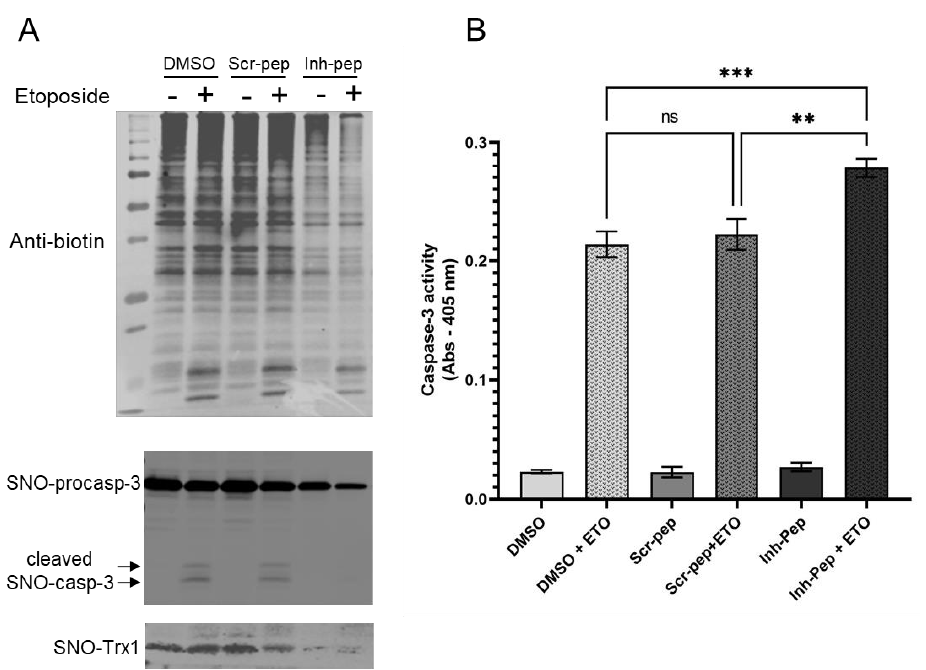
Figure 4. Inhibitory peptide by reducing S-nitrosation in Jurkat T cells increases etoposide-dependent caspase-3 activity. ( A ), Representative Western blots of biotin switch assays of Jurkat T cells ± etoposide (ETO) treated with DMSO, scramble peptide (Scr-pep), or inhibitory peptide (Inh-pep). Upper panel is a blot of a non-reducing gel probed with anti-biotin showing the levels of S-nitrosation in Jurkat cells under different conditions (left lane contains the M.W. markers). Lower panels indicate the levels of S-nitrosated pro-caspase-3, cleaved caspase-3 and Trx1 after avidin purification of the biotinylated samples from the upper panel. n = 3; ( B ) Caspase-3 activity was measured with the same sample’s treatment of Figure 4A. The experiments, measured in duplicate, were repeated independently 3 times. ** p < 0.001; *** p < 0.0005. For clarity, the highly significant ( p < 0.0001) increase in apoptosis with ETO under the three conditions is not shown. ns: not significant.